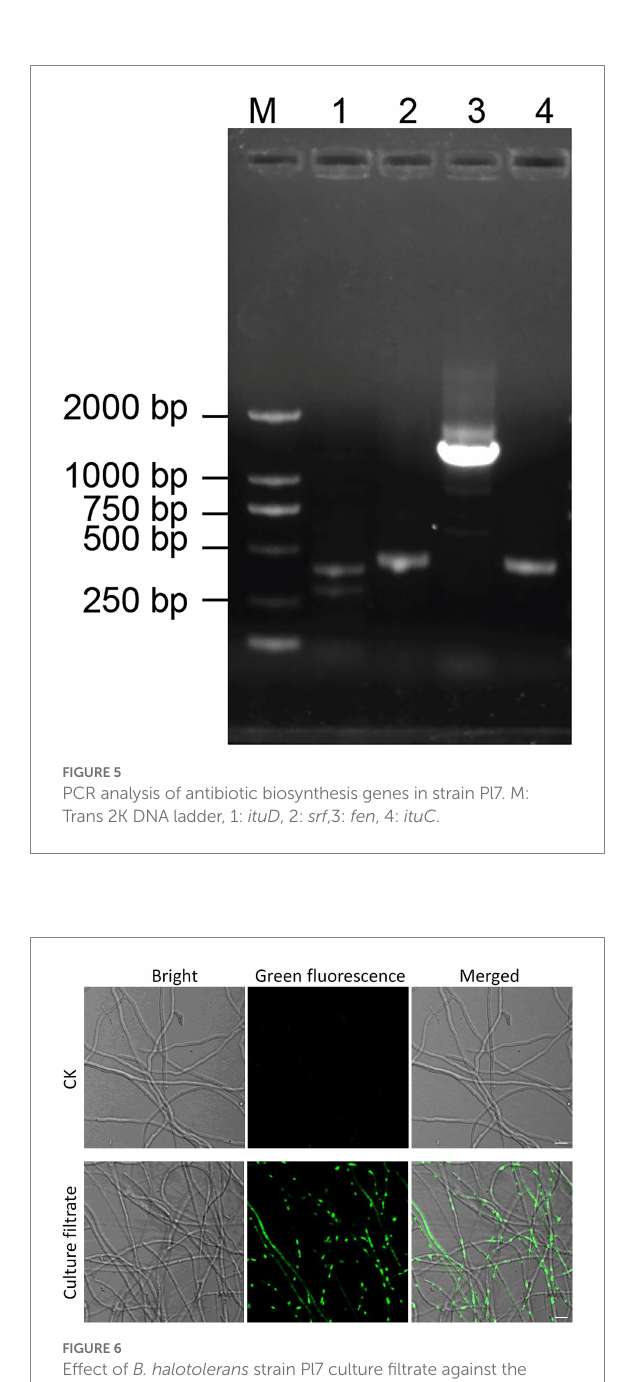
(Figure 8). CBZ treatment did not inhibit CBZ-resistant isolate- caused apple ring rot (Figure 8). At 3 dpi or 5 dpi, the average lesion diameter of CK was 1.28 cm or 2.07 cm, while the strain Pl7-treated fruits was significantly lower (0.42 cm or 1.07 cm; Figure 8C). These data revealed that B. halotolerans strain Pl7 was similarly effective in preventing CBZ-resistant isolate-caused apple ring rot.